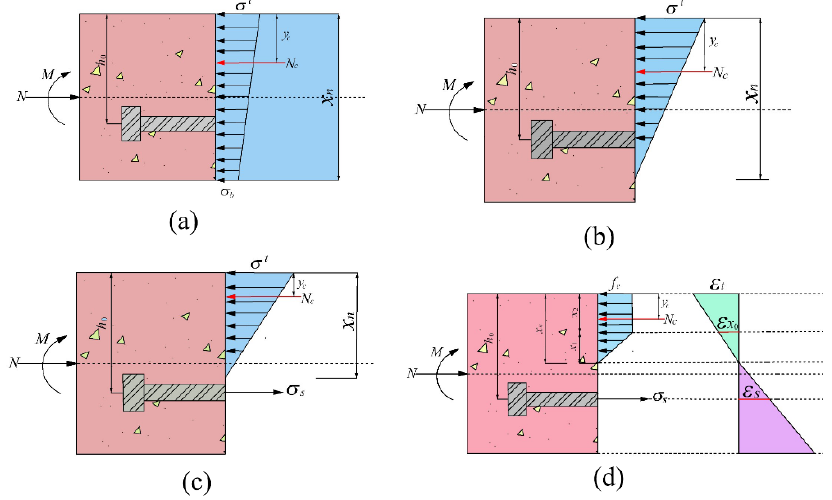
where Stage 1: Whole section in compression. As shown in Figure 14, the stress pattern of concrete in the compression zone is replaced by an equivalent trapezoidal or triangular stress pattern. The condition is that the magnitude of compressive stress resultant force is equal, and the position of the resultant force is identical; σ t is the compressive stress at the lower part of the segmental joint, and σ b is the compressive stress at the upper part of the segmental joint. Nc is the resultant force of the concrete under compression, and y c is the distance from the point of action of the resultant concrete force to the upper edge of the segmental joint.